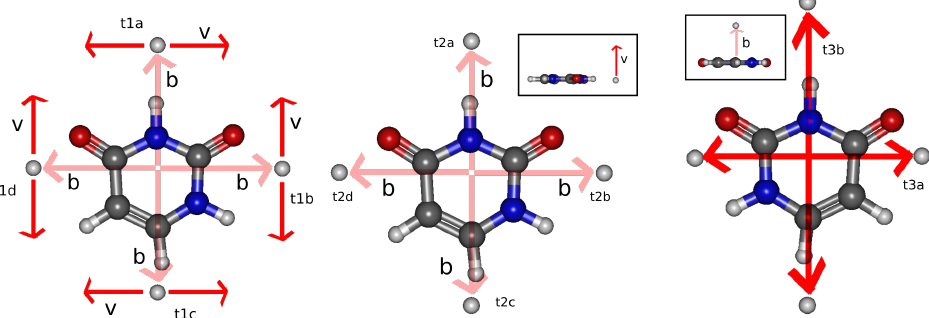
Figure 2. Projectile trajectories characterized by the set {ˆ b , ˆ v }. Taking into account the planar geometry of the molecule, the 24 trajectories of a 6-point Cotes formula are reduced to the 16 trajectories repre- sented in the figure. The trajectories are classified in families attending to whether ˆ v is perpendicular (t1), contained in (t2) or parallel to (t3) the molecular plane, and subfamilies t1x, t2x, and t3x that share the same unitary vectors (ˆ v , ˆ b